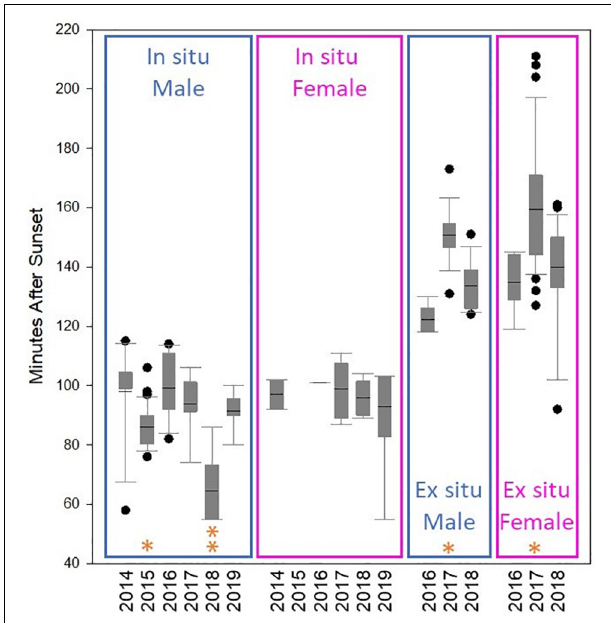
FIGURE 2 | Initial spawn time in minutes after sunset of in situ and ex situ Dendrogyra cylindrus colonies separated by year and by gender. Box plot metrics include: mean (black line), 25th–75th percentile (box), 10th–90th percentile (whiskers), and outliers (dots). In 2015 (*), in situ males spawned significantly earlier than in 2014 and 2016. In 2018 (**), in situ males spawned significantly earlier than in 2014, 2016, 2017, and 2019. There were no significant differences in female spawn time among years. Among ex situ fragments, males and females spawned significantly later in 2017 (*) than in 2016 and 2018.